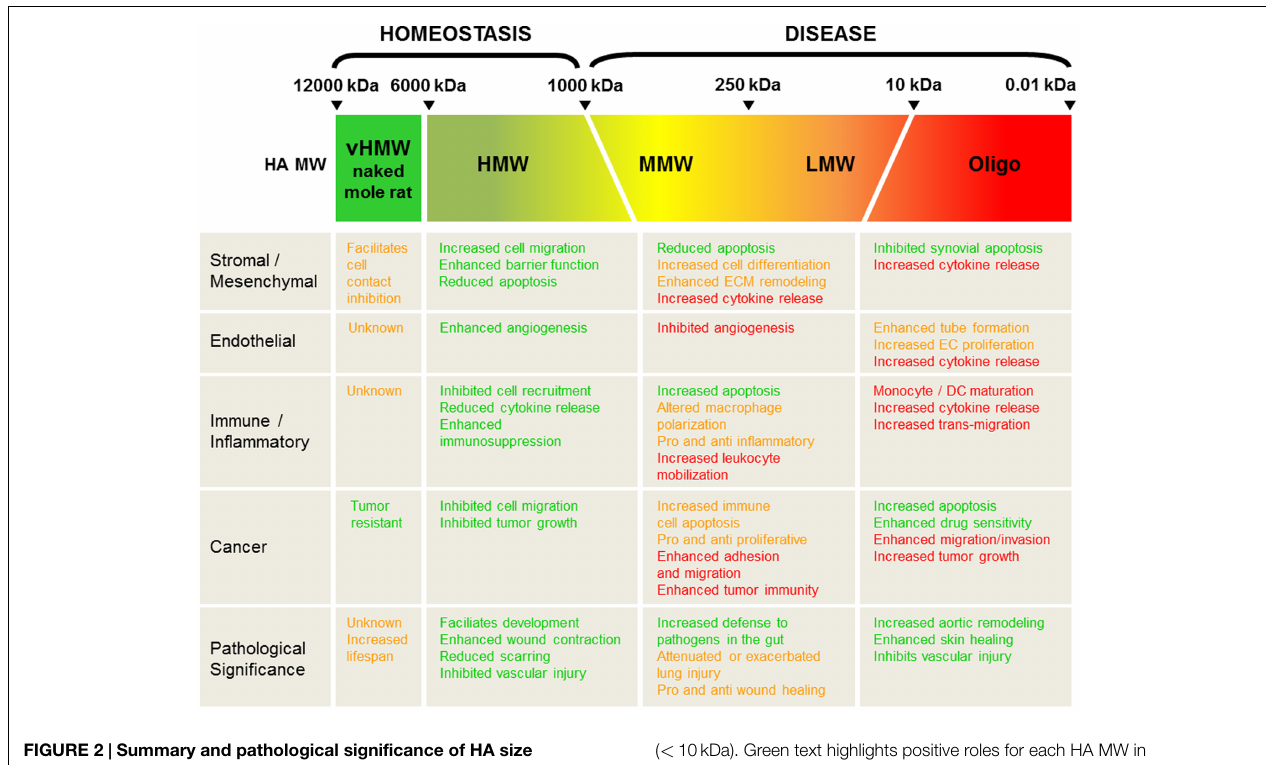
FIGURE 2 | Summary and pathological significance of HA size in vivo . HA molecular weight (MW) is divided into very high (vHMW 6000-12000kDa; naked mole rat HA), high (HMW > 1000kDa), medium (MMW 250-1000kDa), low (10-250kDa), and Oligo-HA